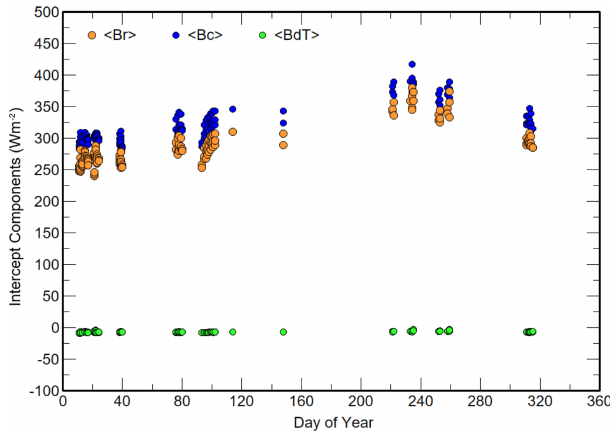
Figure 5. The linear LSQ slope <B r > , <B c > and <B d T > com- ponents that generate <τW atm > for 244 calibrations in